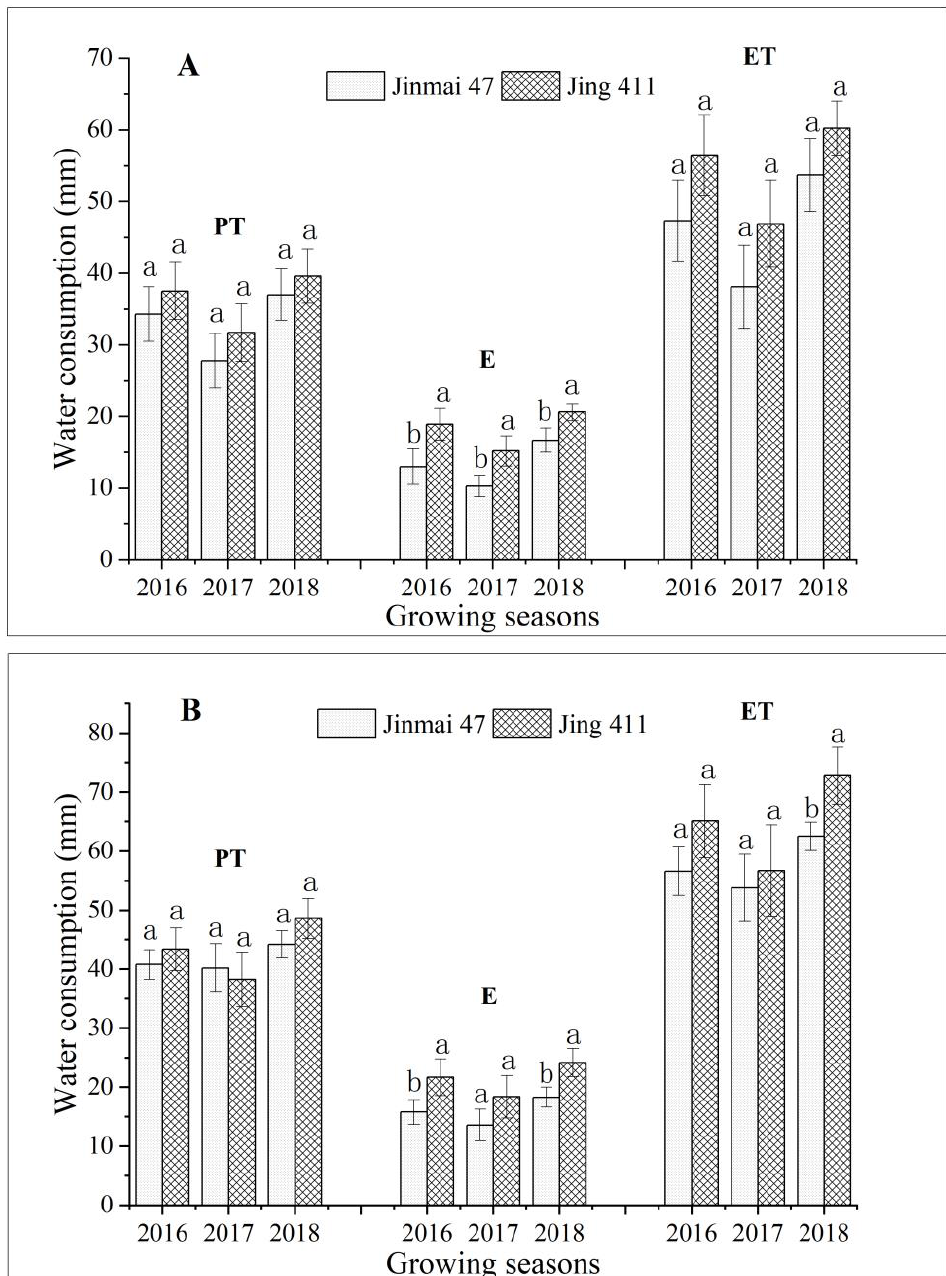
Figure 2. Population-scale transpiration (PT), soil evaporation (E), evapotranspiration (ET) during the jointing to the early grain filling stages for the genotypes Jinmai 47 and Jing 411 under ( A ) rain-fed (RF) and ( B ) supplemental irrigation (SI) conditions. The PT, E and ET were measured for 25 days from 17 April to 11 May in the 2015–2016 growing season; for 25 d from 18 April to 12 May in the 2016–2017 growing season and for 22 d from 22 April to 11 May in the 2017–2018 growing season. For each water use parameter in each growing season, different letters indicate significant differences between the two genotypes at p < 0.05 based on the LSD test. Vertical bars indicate the standard deviation.